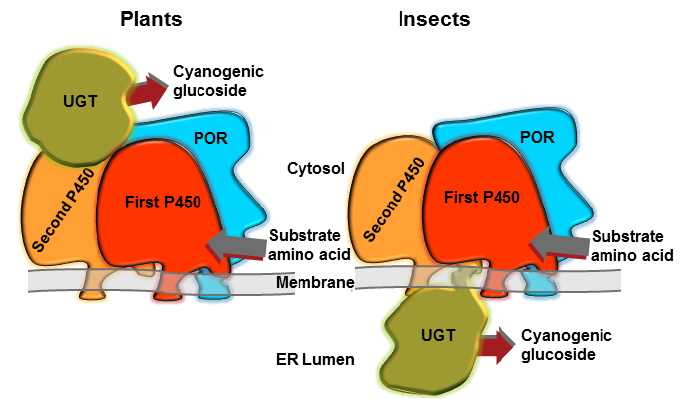
Figure 2. Hypothetical representations of metabolons for the biosynthesis of CNglcs in plants and insects. Adapted from [29]. The components are not necessarily present in stoichiometric amounts in vivo.